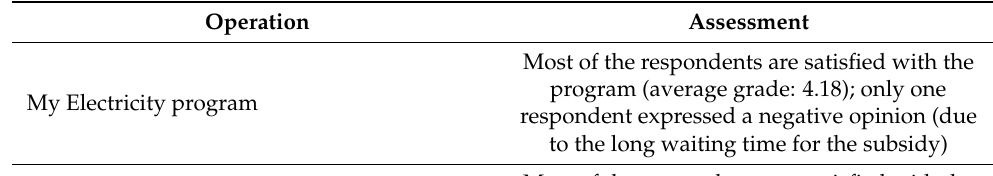
Figure 6. Answers to questions about the difficulty of completing the subsidy form ( n = 57). Source: own study. Table 6. Assessment of the operation of PV micro-installations ( n =